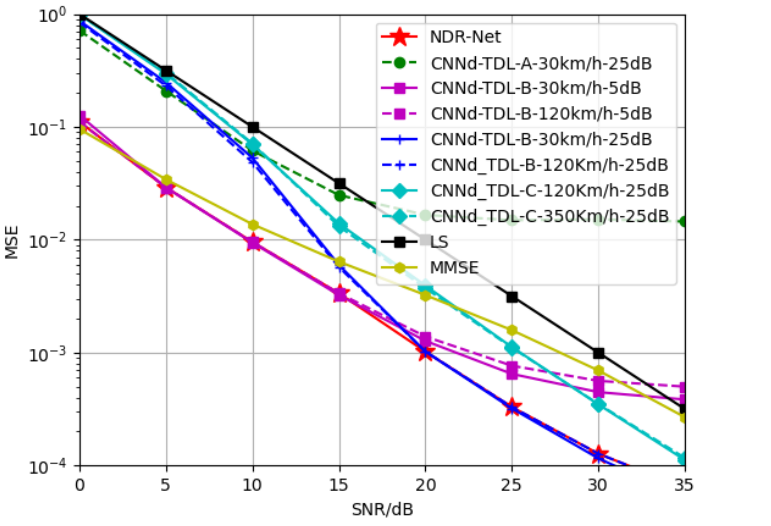
Figure 13. Generalization performance of different channel estimators when the test channel is TDL-B, SNR = 15 dB, Velocity = 120